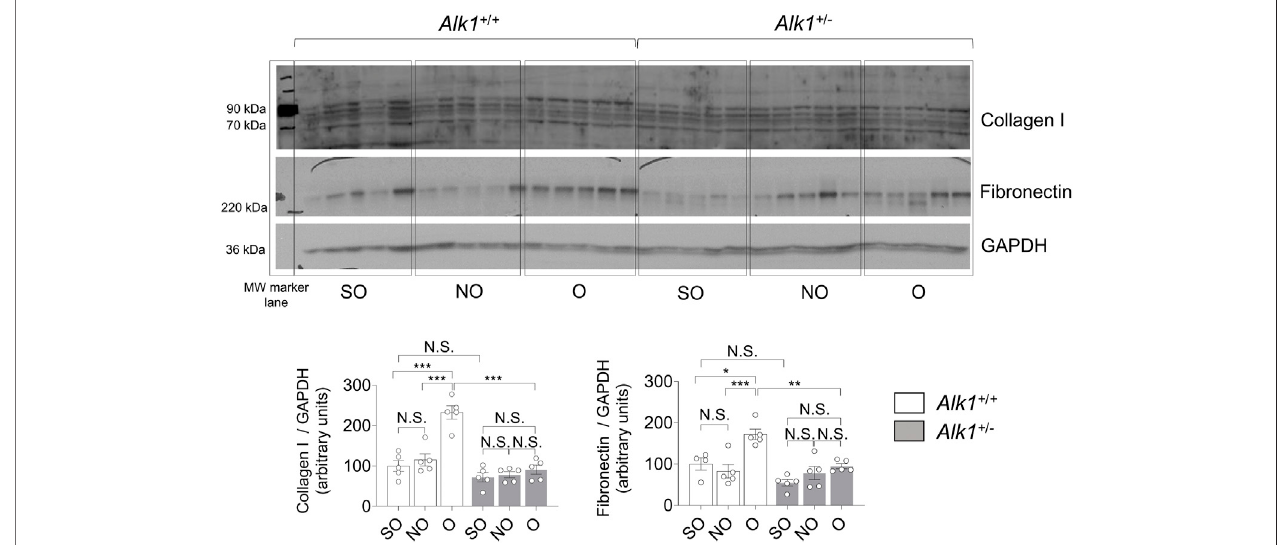
FIGURE 3 | Obstructed kidneys from Alk1 +/ − mice show reduced ECM protein levels after 3 days UUO. Western blot analysis of collagen I and fi bronectin protein expression inSO,NOand Okidneys from Alk1 +/+ and Alk1 +/ − mice,and quanti fi cation ofthecorrespondingdensitometry.Barsrepresenttheratiobetweentheproteins and GAPDH, used as loading control. * p < 0.05; ** p < 0.01; *** p < 0.001; N.S = Not statistically signi fi cant (Two-way ANOVA). One statistical outlier was removed from the analysis of fi bronectin in a SO mice from Alk1 +/+